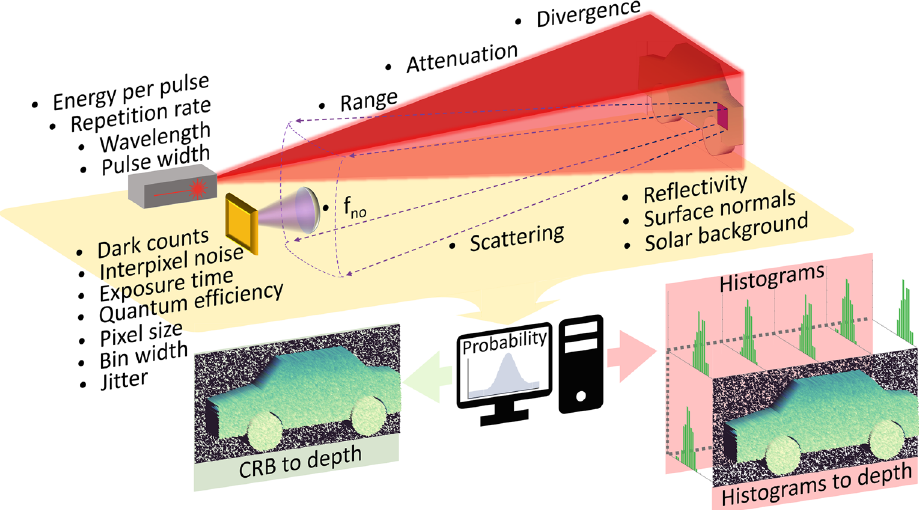
the SPAD sensor then recieves light from a region of the target plane (illustrated by the square on the vehicle) subject to the properties of the target, scattering, the aperture of the collection lens, and the parameters of